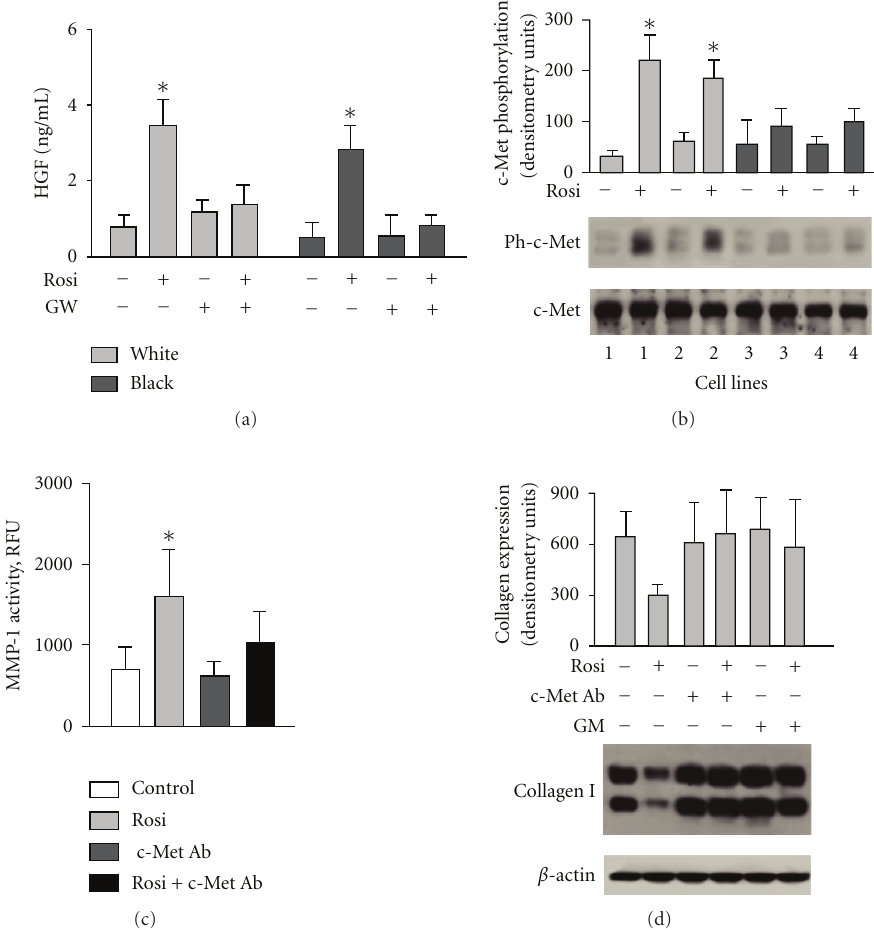
Figure 5: E ff ects of rosiglitazone in lung fibroblasts are mediated in part by HGF. (a) Rosiglitazone induces HGF expression in SSc lung fibroblasts. Each bar represents the mean ± SD of duplicate determinations in four independent experiments. (b) E ff ect of rosiglitazone on c-Met receptor phosphorylation in lung fibroblasts from white (cell lines 1 and 2) and black (cell lines 3 and 4) patients with SSc-ILD. (c) Anti-c-Met antibody modulates MMP-1 activity in white SSc lung fibroblasts. (d) Downregulation of collagen type I by rosiglitazone in white SSc lung fibroblasts depends on c-Met and MMP-1. Quantitative results of densitometric analysis of immunoblots presented in (b) and (d) are shown; values are the mean and SD from 4 independent experiments. ∗ P < 0 . 05 versus unstimulated